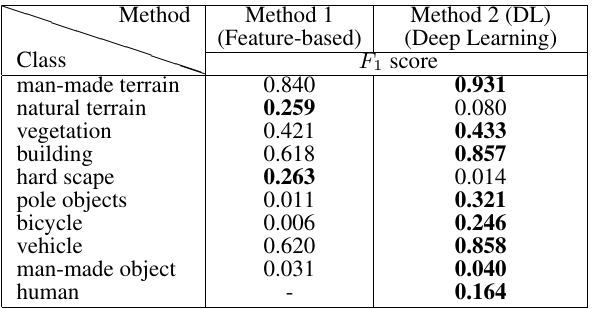
Table 2. Comparison of F 1 scores of both methods, calculated in evaluation against the Testset 1. Bold: the highest score for each class